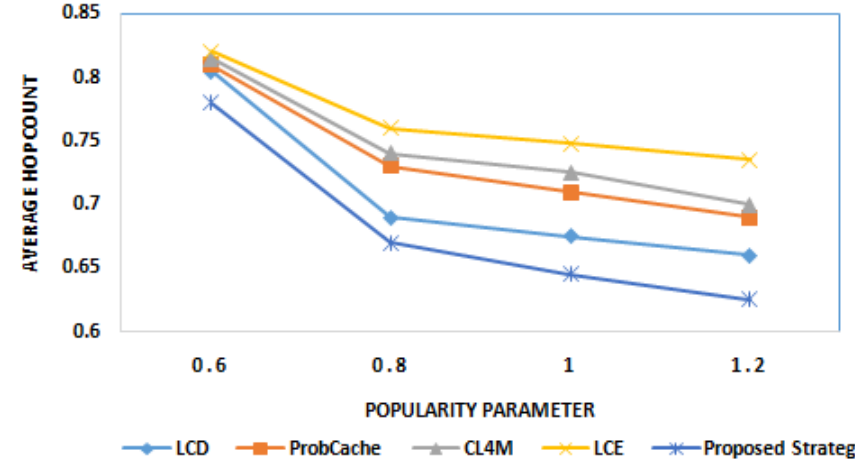
Figure 7. Average hop count for different popularity parameter α